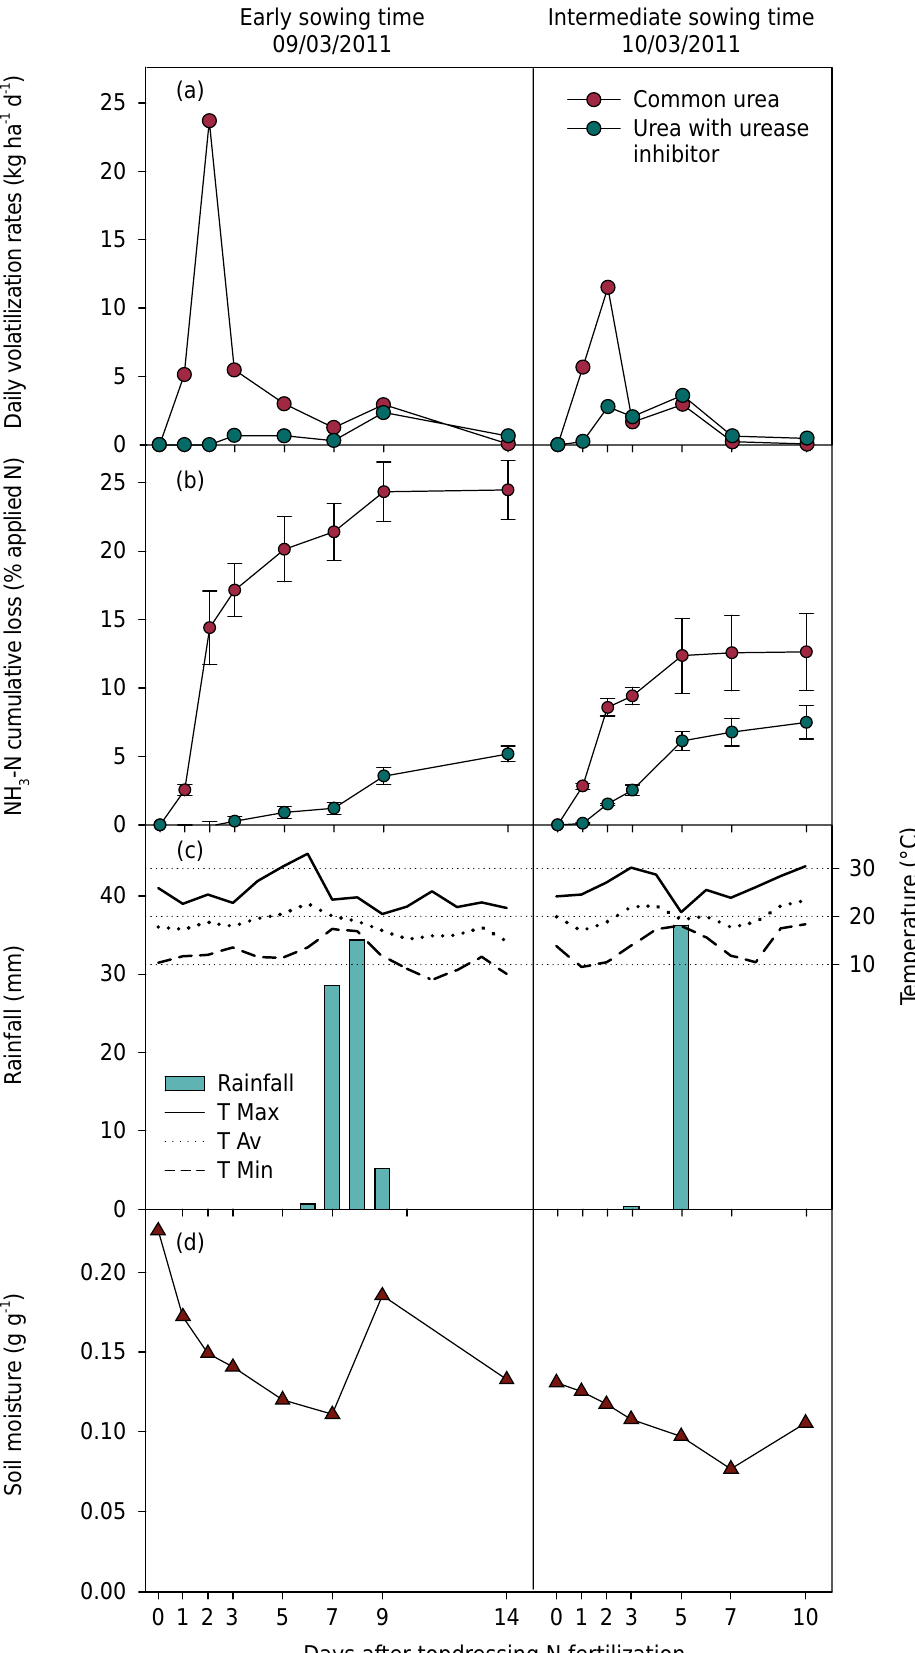
Figure 1. Daily volatilization rates (a) and NH 3 -N cumulative losses (b) from common urea and urea with a urease inhibitor applied to corn at two different sowing times (early and intermediate). Rainfall and daily air temperature [maximum (T Max), average (T Av), and minimum (T Min)] (c), and soil moisture (d) in Experiment I. Vertical bars represent mean standard